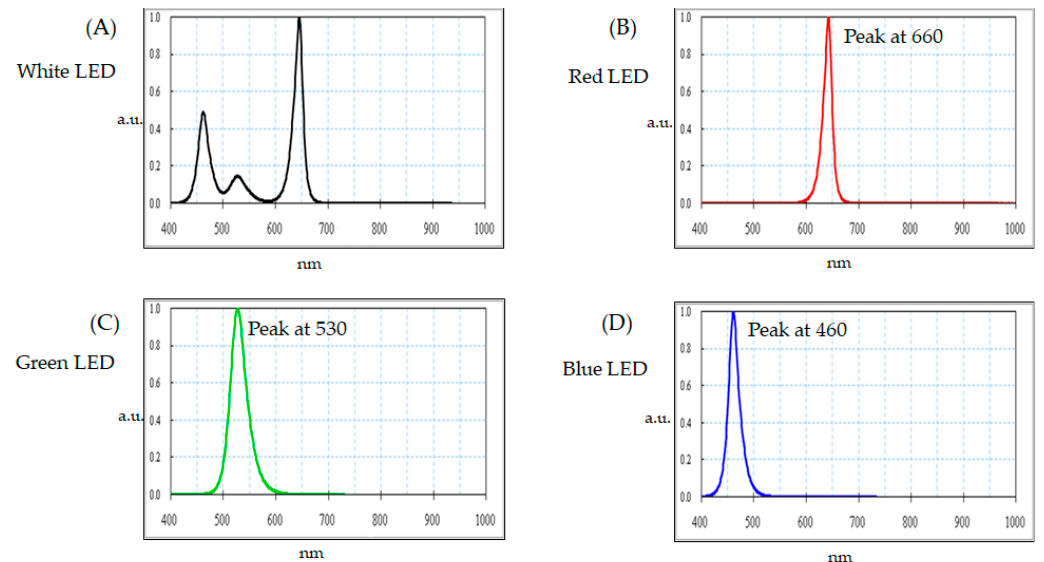
Figure 1. A sequent process of the thin-film transistor (TFT) glass in the architecture of automatic optical inspection. In which ( A ) is the alignment and conveyor-in, ( B ) is the captured image site, and ( C ) is the conveyor-out.